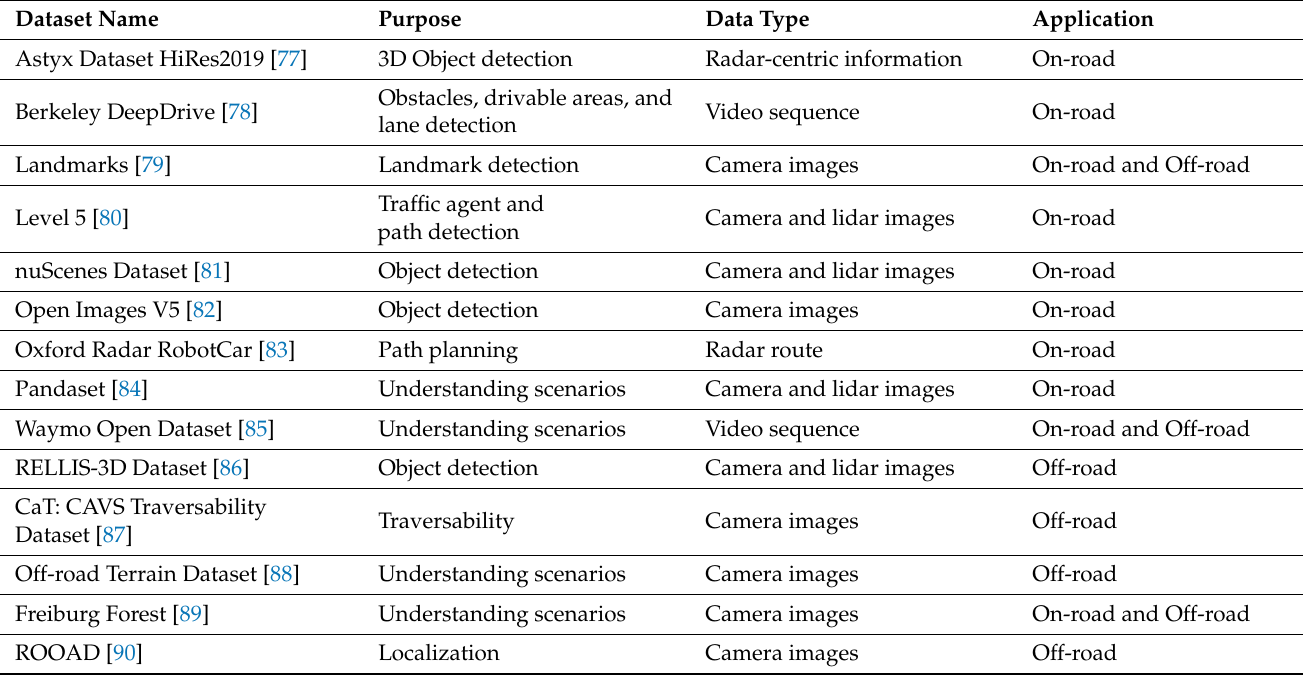
Table 6. Some publicly available datasets for autonomous